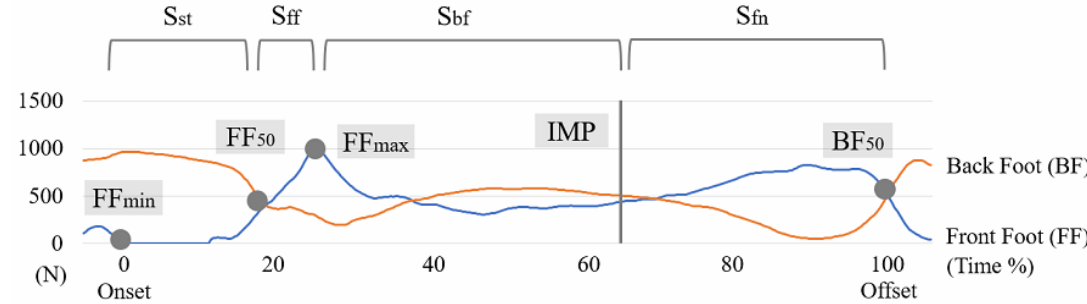
Figure 2. The swing cycle could be divided into four stages by five events. The five events are FF min , FF 50 , FF max , IMP, and BF 50 (FF stands for the ground reaction force (GRF) of the front foot, and IMP is the impact moment). The four stages are S st (start stage), S ff (front foot stage), S bf (back foot stage), and S fn (finish stage).